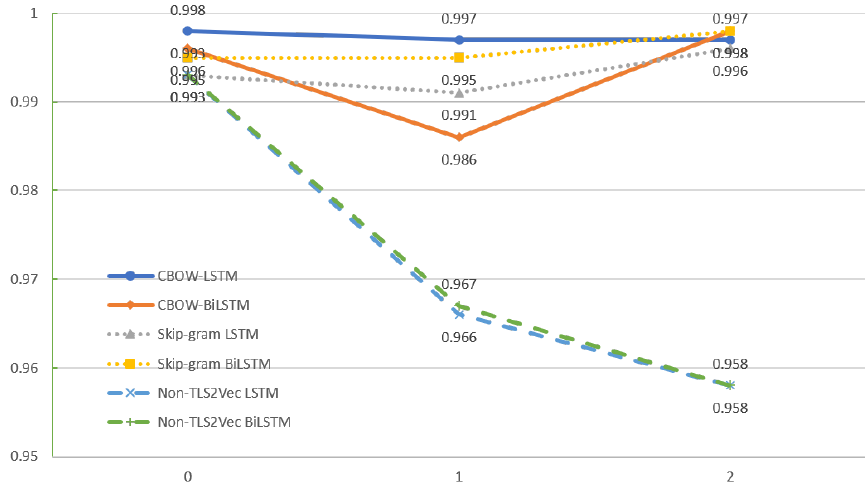
Figure 3. The evaluation between TLS2Vec with CBOW, TSL2Vec with Skip-gram, and Non-TLS2Vec. The x-axis is the payload from zero, one, and two or more payloads, while the y-axis is the F1 score.